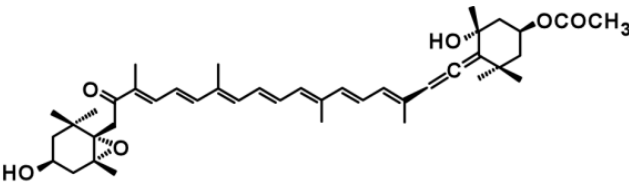
Figure 1. Molecular structure of